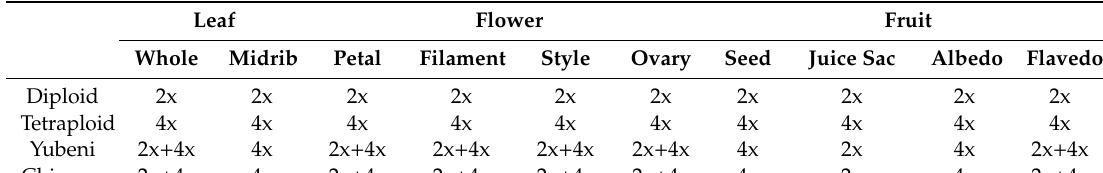
Table 1. Flow cytometric analysis of each organ and tissue in the diploid, the tetraploid, the Yubeni, and the chimera of the Meiwa kumquat.